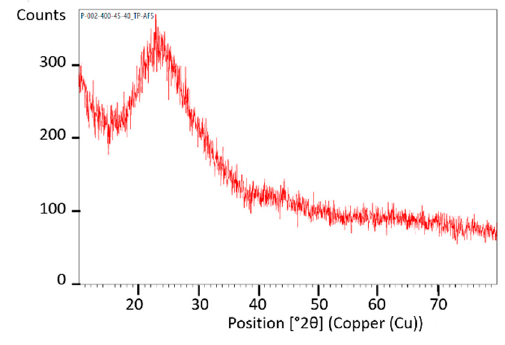
Figure 3. XRD analysis of 0.2–0.1 mm size fraction of solar cell.